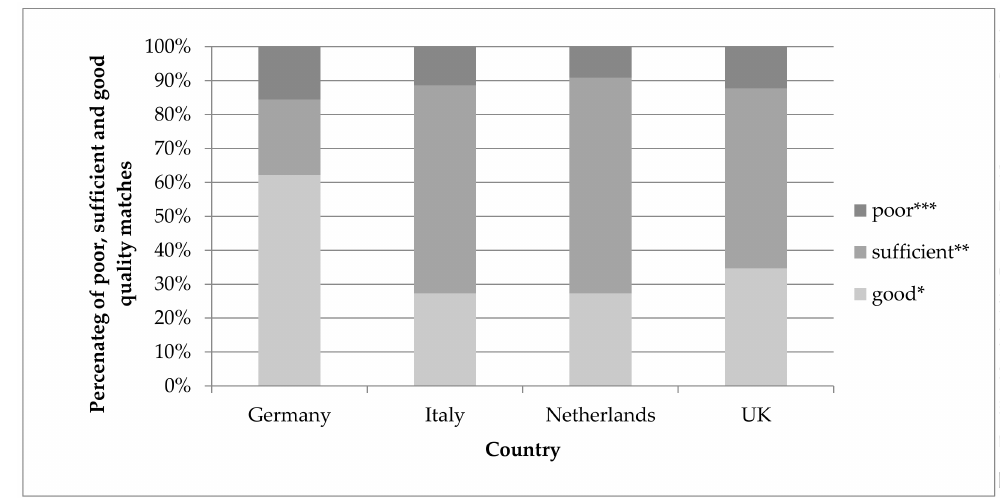
Figure 6. Percentage of poor, sufficient and good quality matches by country as selected and judged by the human experts. * Good—matches in all parameters; ** sufficient—matches in the name and group, but not in all descriptors; *** poor matches—all other matches.